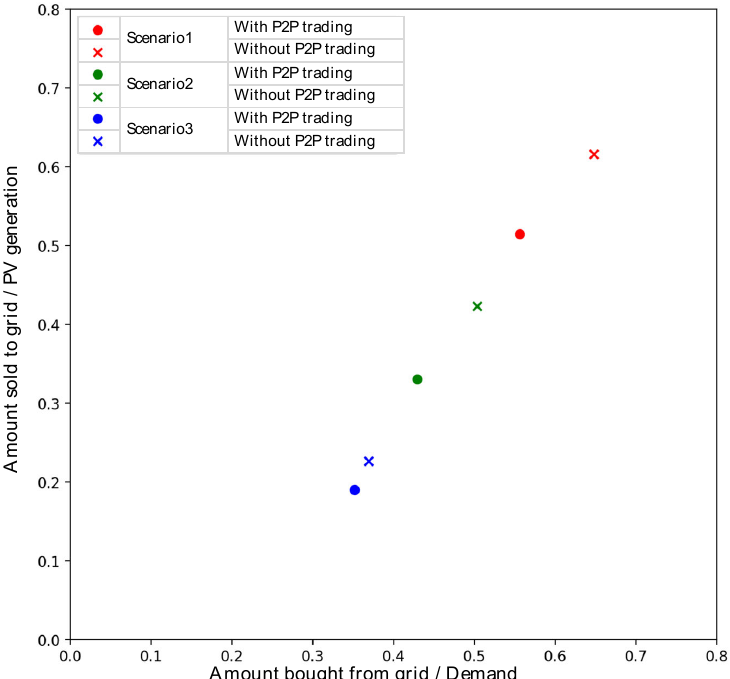
Figure 11. Differences in the degree of load on the electricity system for the entire community with and without P2P trading based on resource ownership scenarios.